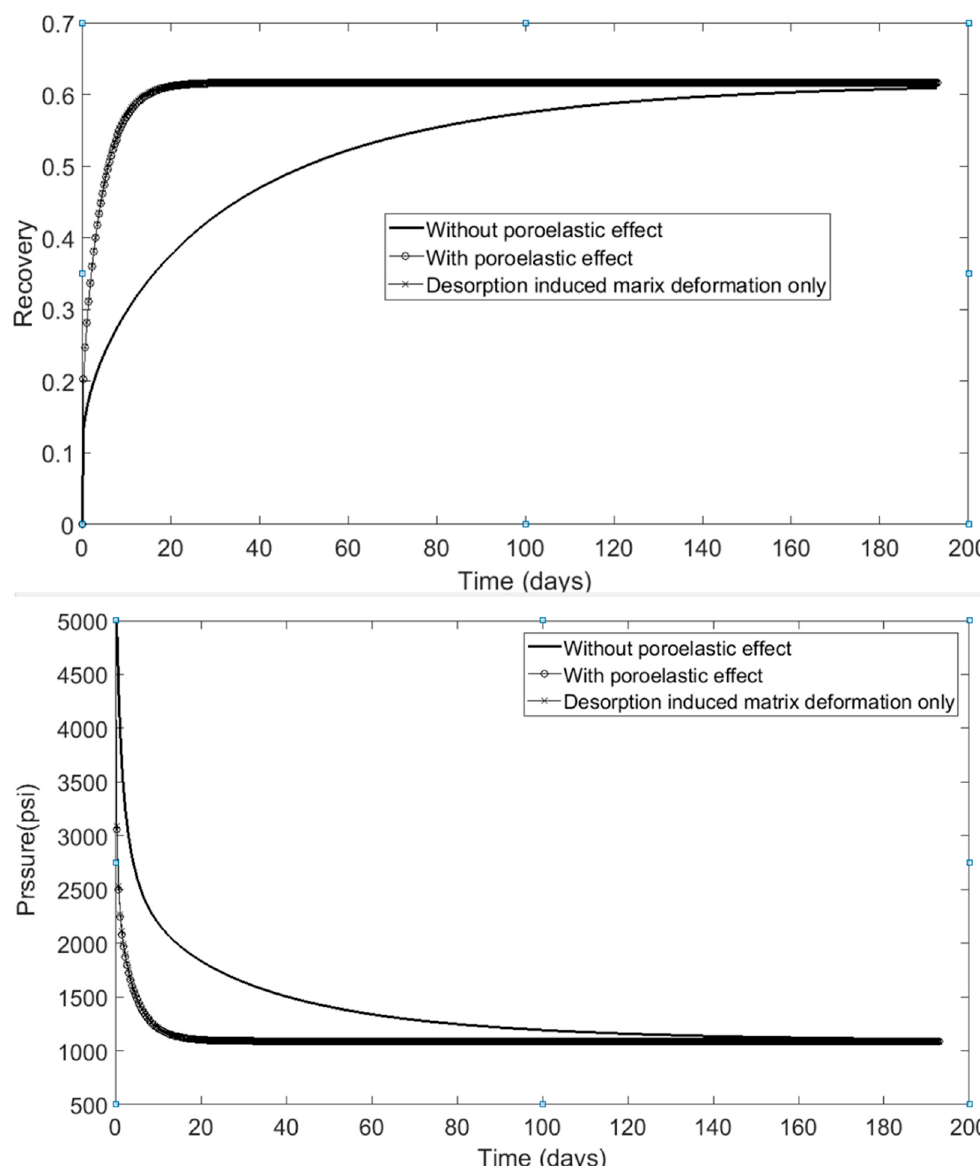
Figure 5. Pressure decay ( bottom ) and ultimate recovery ( top ) comparisons of models with desorption-induced matrix deformation only.